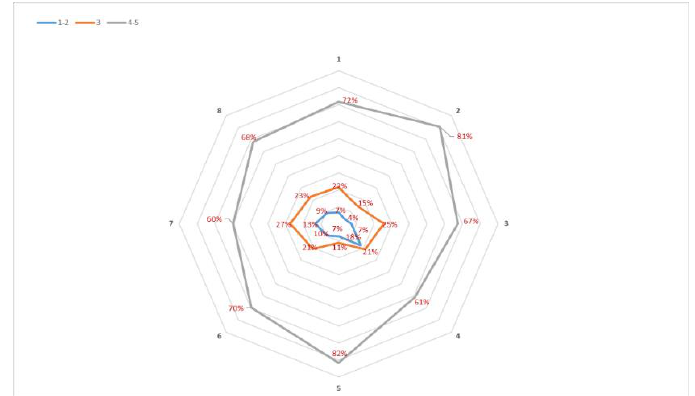
Figure 5: Sample B Investigation during Covid-19